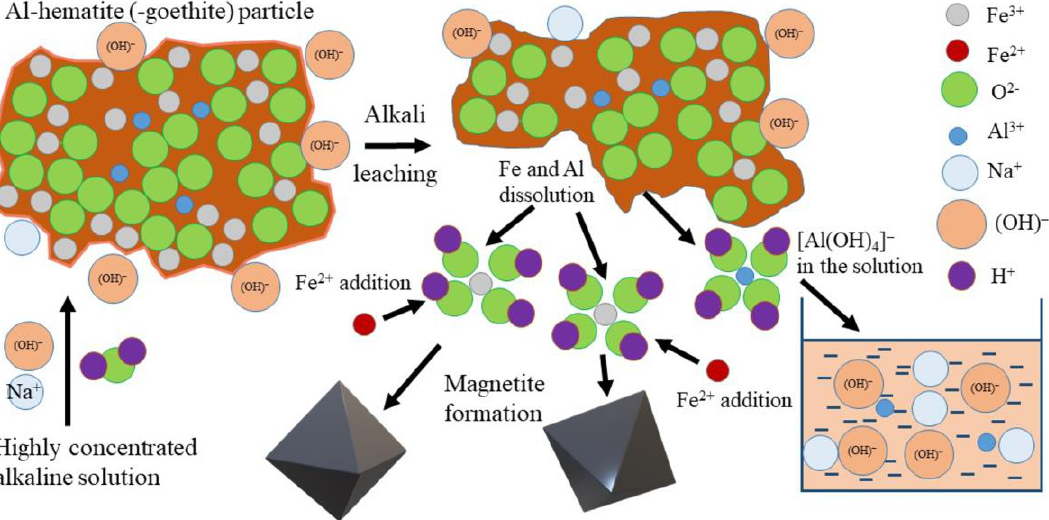
Figure 12. The schematic mechanism of high-iron BR leaching by a highly concentrated NaOH so- lution in the presence of Fe 2+ .